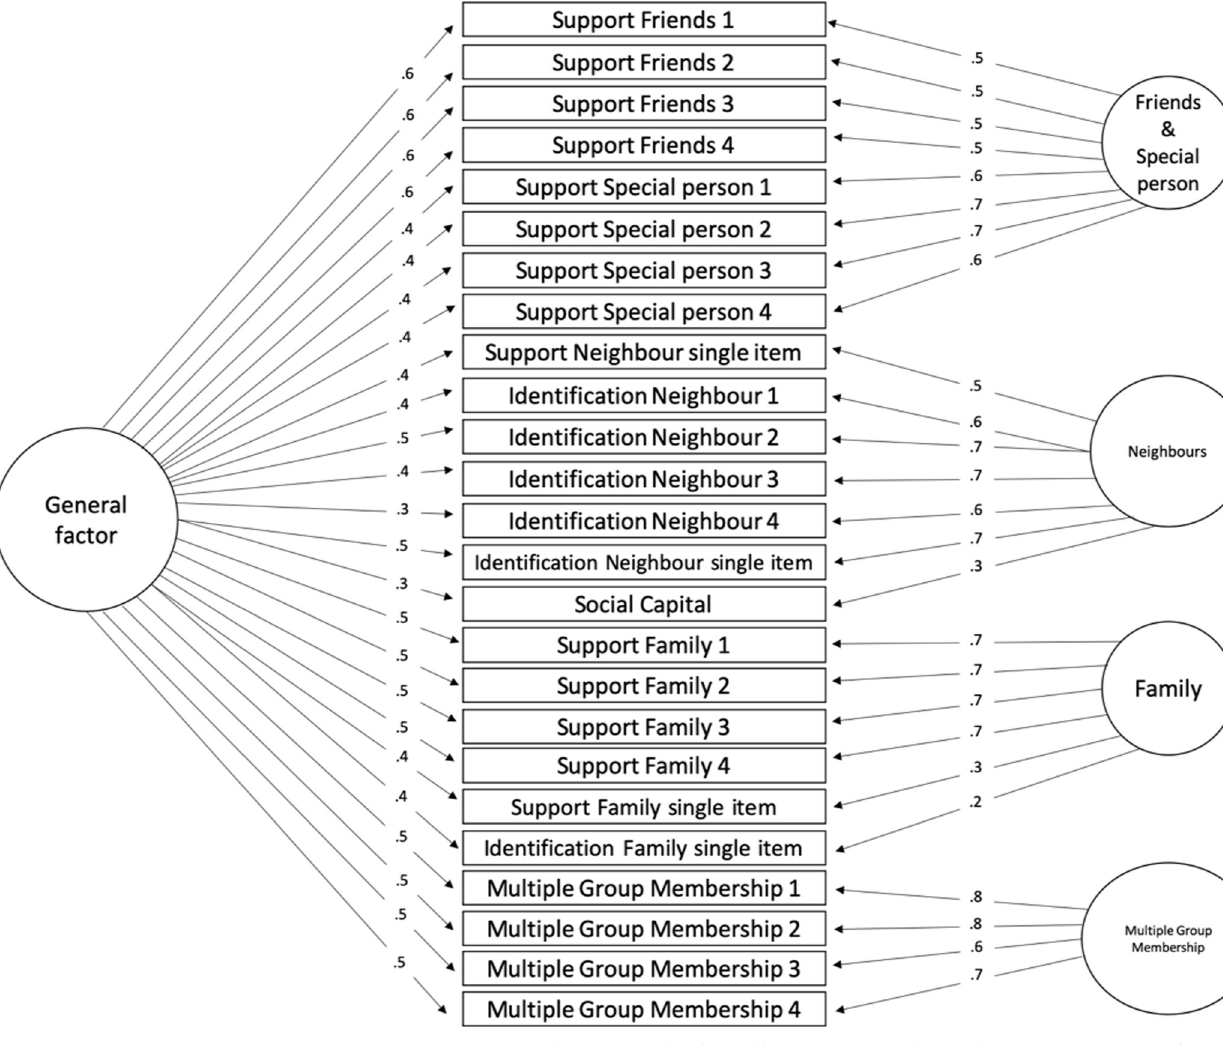
Fig 2. Bi-factor, Omega results with 4 factors. Item names correspond to measures listed in Tables 1 & 2 respectively. Numbers on arrows represent factor loadings.